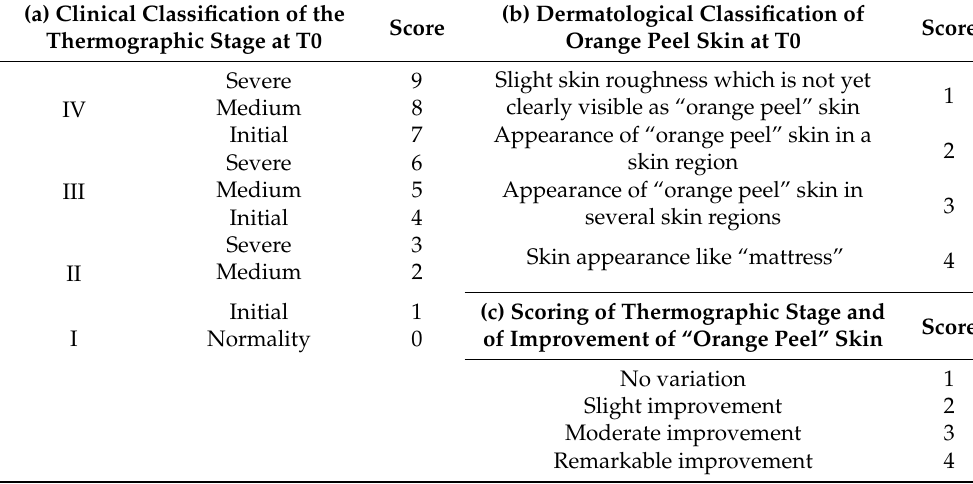
( a ) Termographic evaluation of cellulite-induced alteration of skin microcirculation. ( b ) Dermatological evaluation of cellulite-derived skin imperfections (“orange peel”). ( c ) Scoring of both thermographic evaluation and cellulite-derived skin imperfections after 28 and 56 days of product